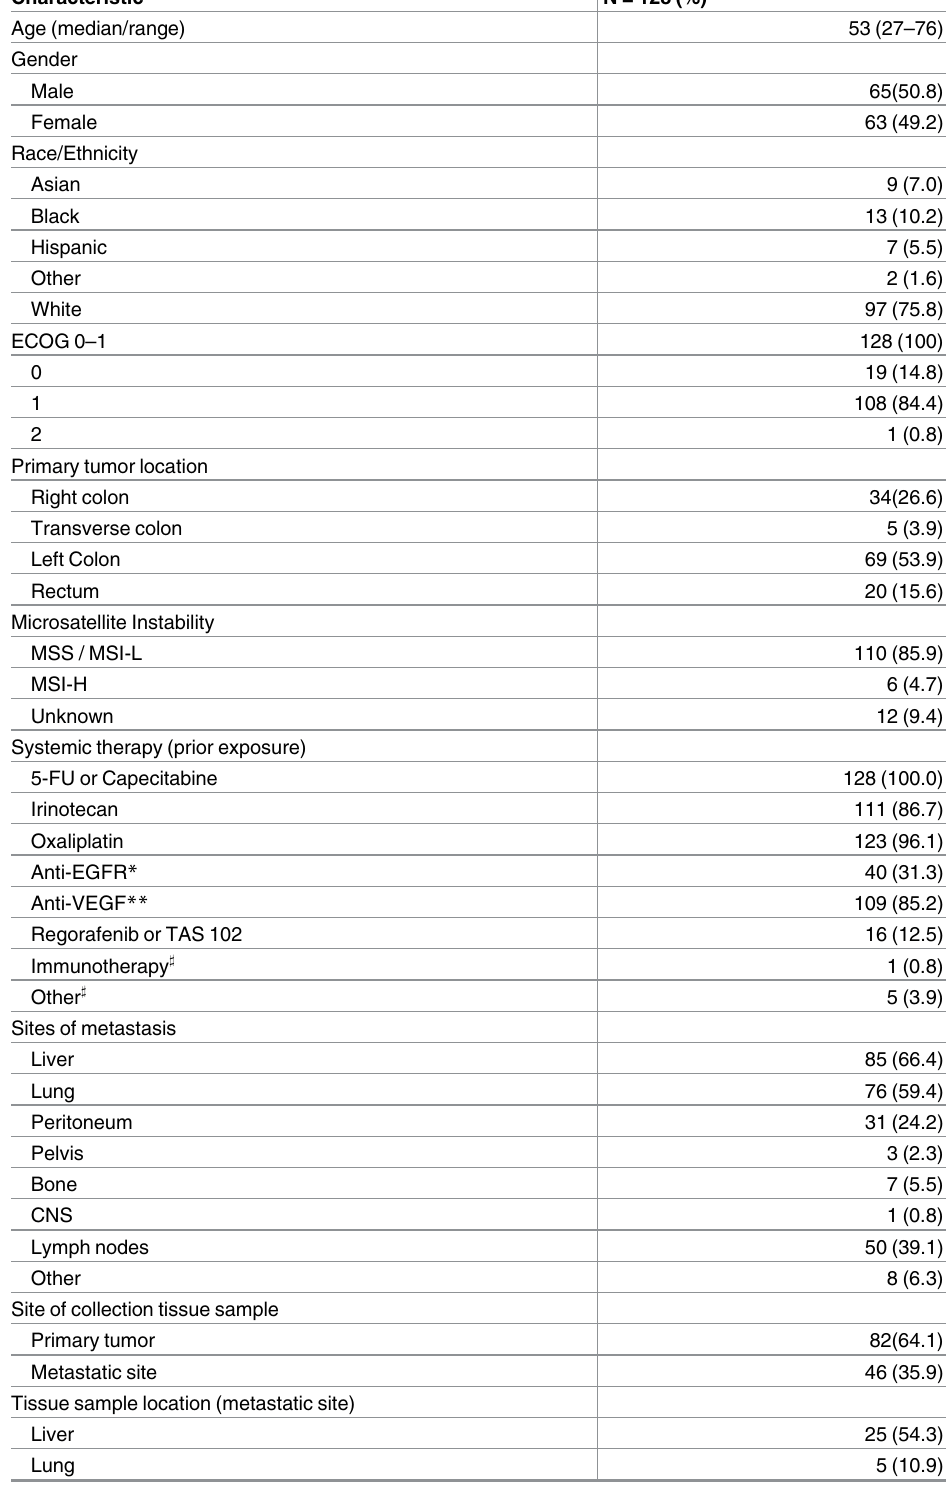
Table 1. Patient demographic